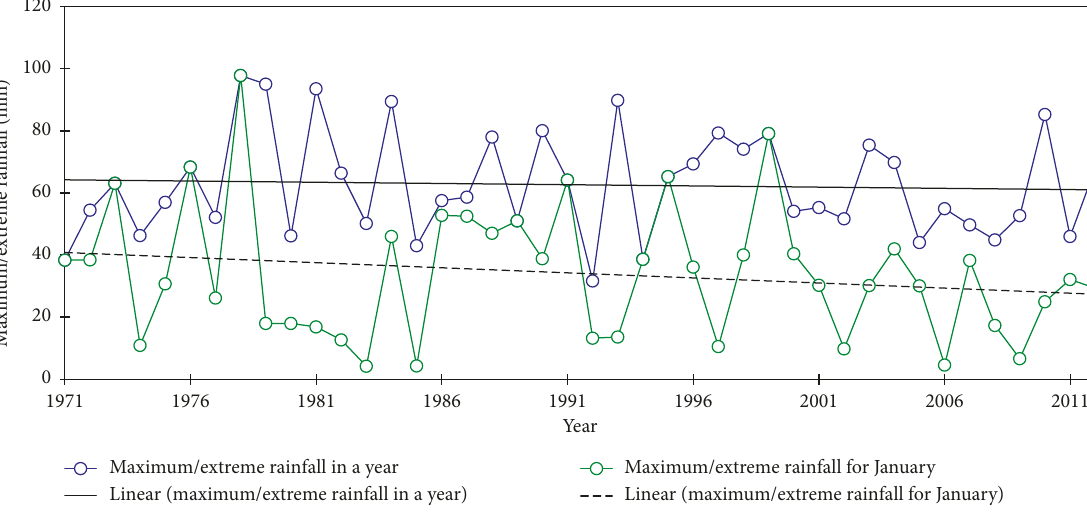
Figure 10: Trend (the Mann–Kendall trend test showed a nonsignificant trend at a 95% confidence interval, p -value > 0.05) for maximum (extreme) rainfall (per year and for the month of January) for Morogoro synoptic (daily rainfall data for the period of 1971–2012, in courtesy of the Tanzania Meteorological Agency, were extracted using an interactive Statistical Package, Instat+ for Windows, version